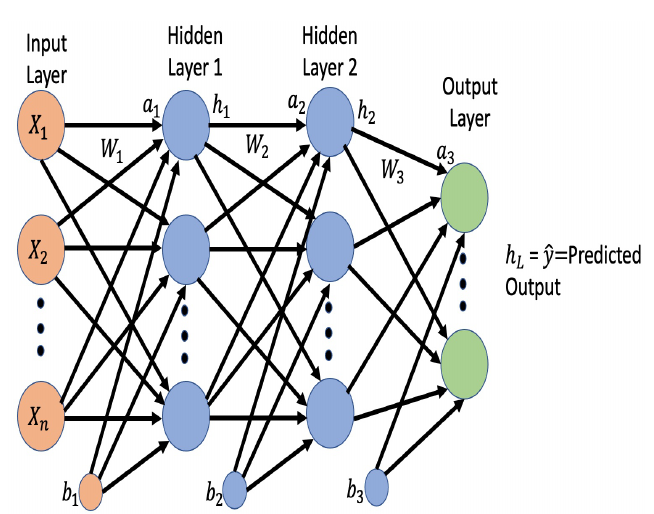
Figure 3. A Multilayer Deep Neural Network